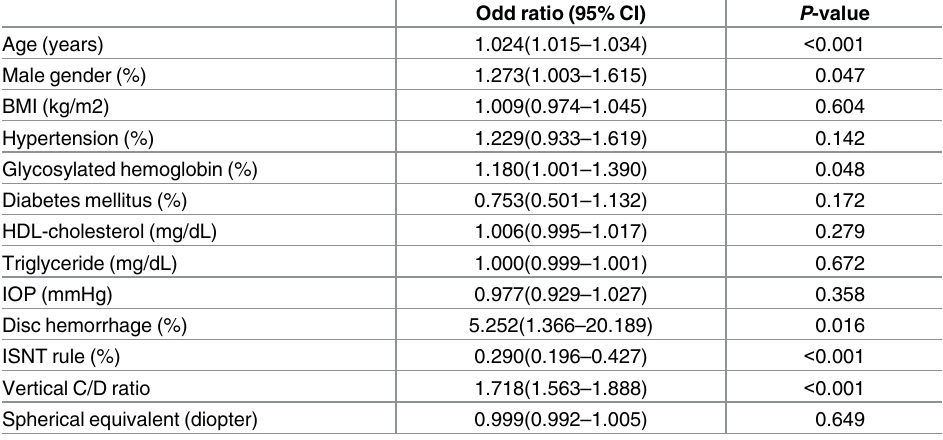
CI, confidence interval; BMI, body mass index; IOP, intraocular pressure; ISNT rule, the thickness of disc rims beginningwith the inferior rim followed by the superior rim, the nasal rim, and the temporal rim; C/D ratio, cup to disc